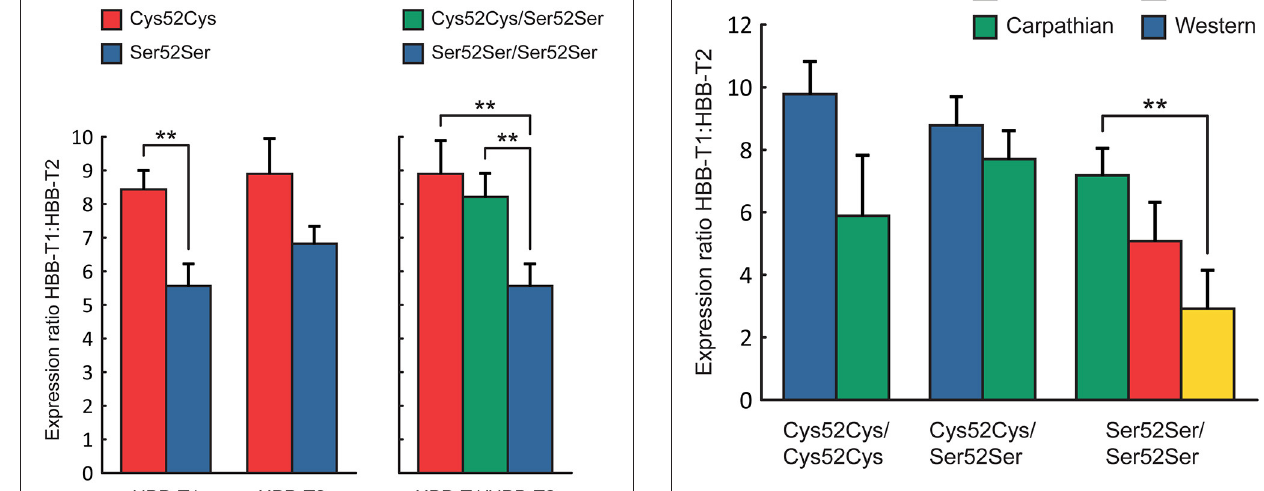
Figure 2 ). There was no significant difference in HBB-T1:HBB-